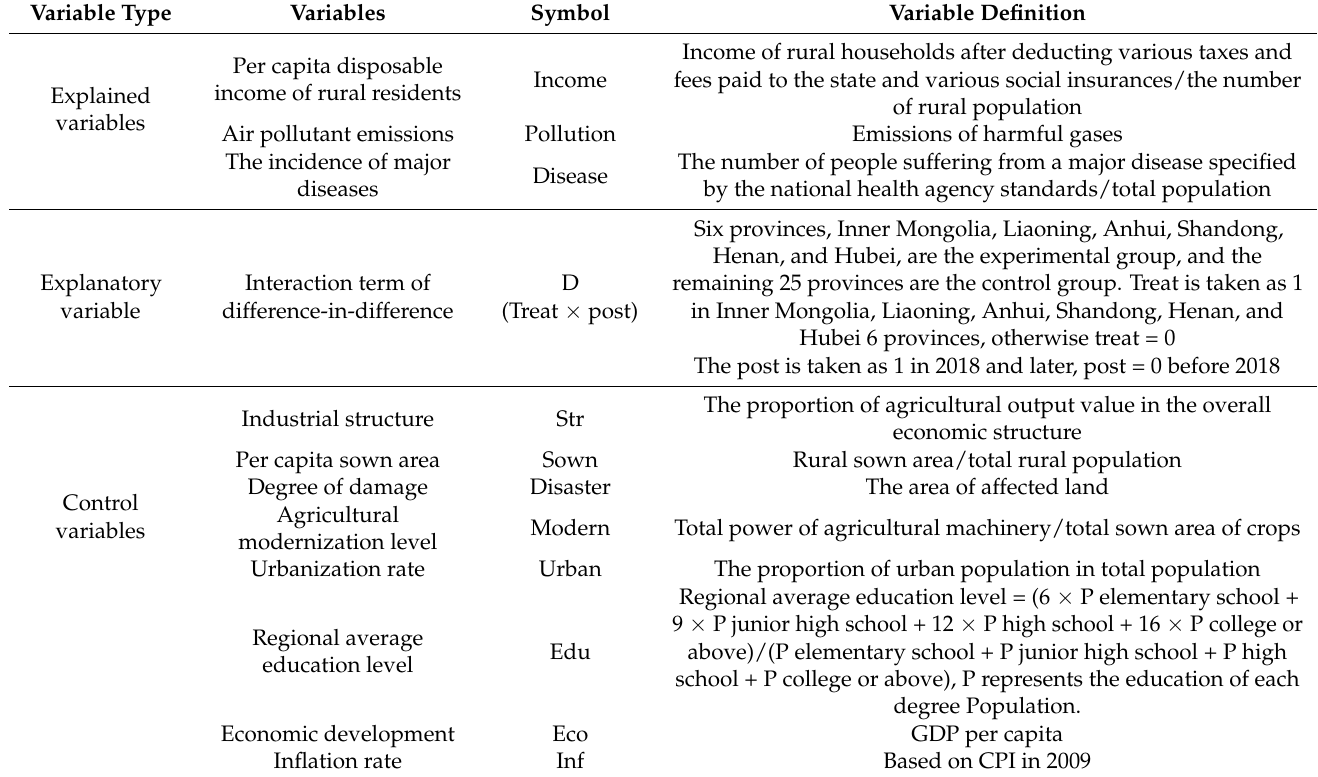
Table 2. Variable